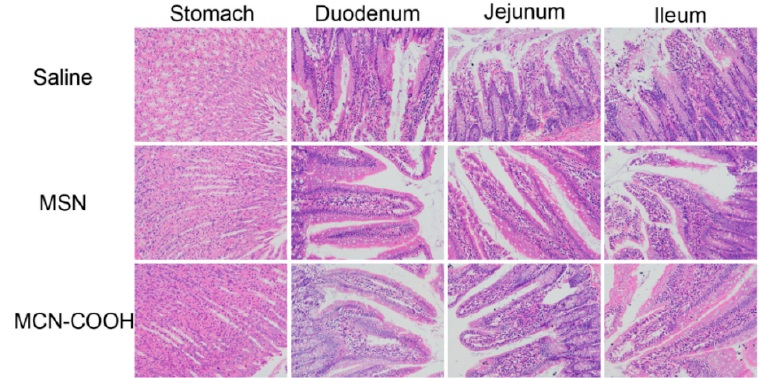
Figure 9. Gastrointestinal mucosa irritation evaluation after oral administration of MSN and MCN–COOH at dose of 100 mg/kg for a week.